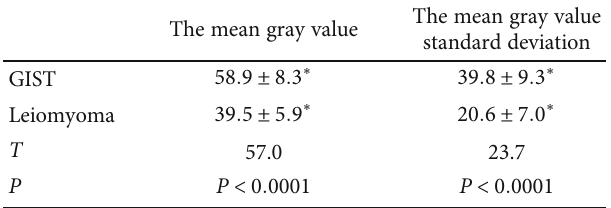
Table 2: Diagnostic consistency of EUS before endoscopic resection.